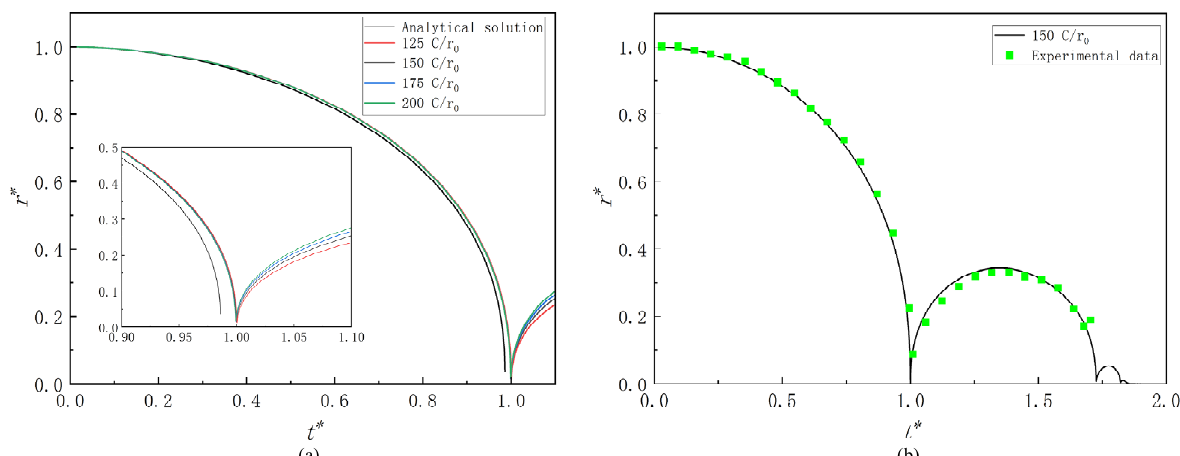
Figure 2. ( a ) Comparison of the bubble radius between the simulation results using different mesh resolutions and the analytical solution; ( b ) comparison of the bubble radius evolution between the numerical and experimental results.